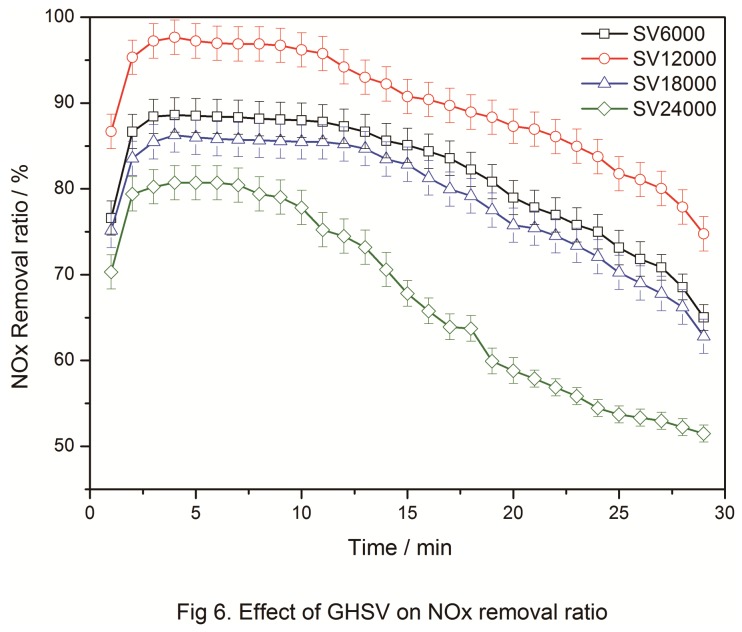
Effect of GHSV on NOx removal.